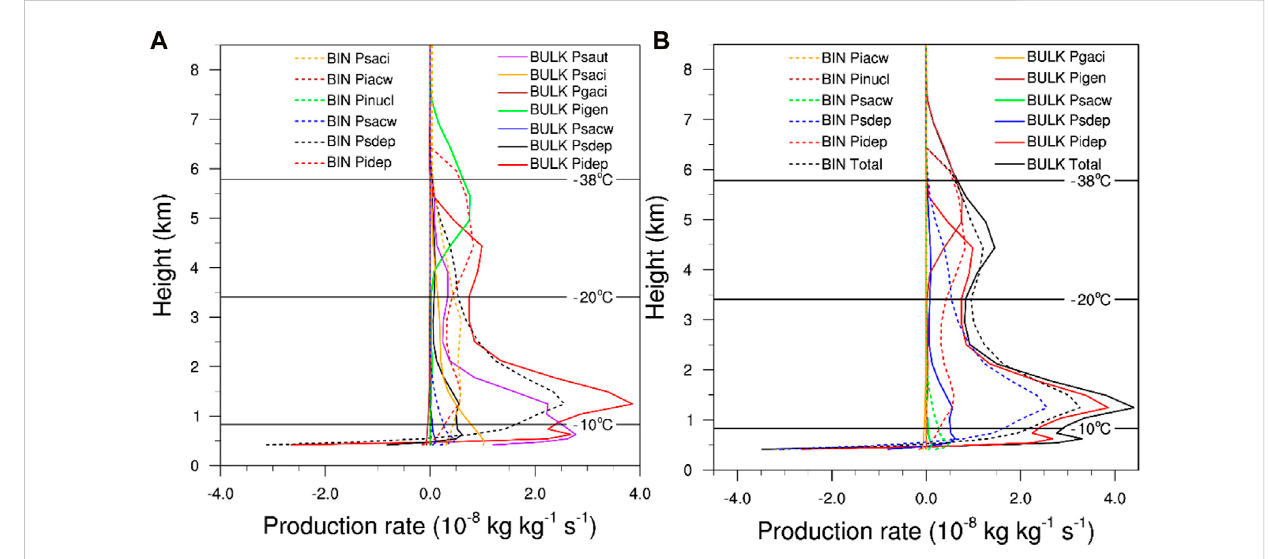
Average vertical pro fi les of production rates of microphysical processes (unit: 10 – 8 kg kg − 1 s − 1 ) from 2000 UTC on February 12 to 1600 UTC on February 13, 2022 for the BULK and BIN simulations: (A) ice-crystal- and snow-related source and sink terms, and (B) budget pro fi les of microphysical conversion for ice crystals and snow combined.